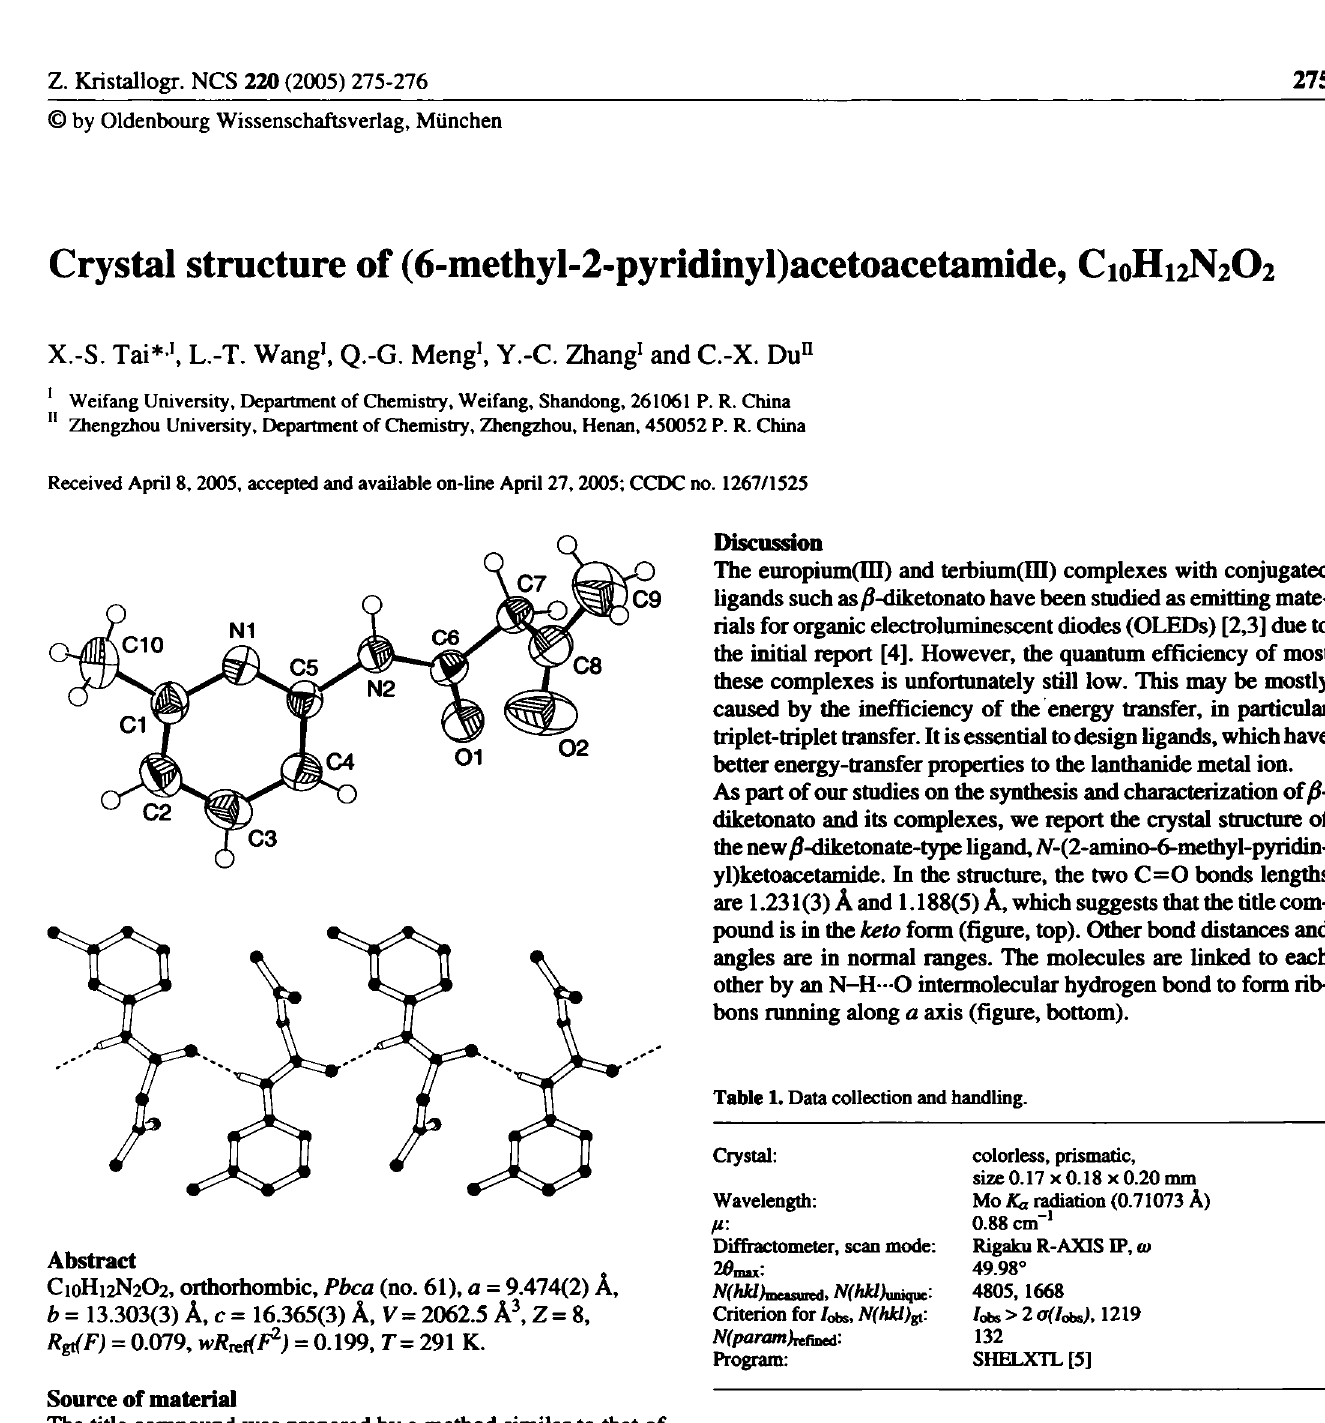
Table 2. Atomic coordinates and displacement parameters (in A 2